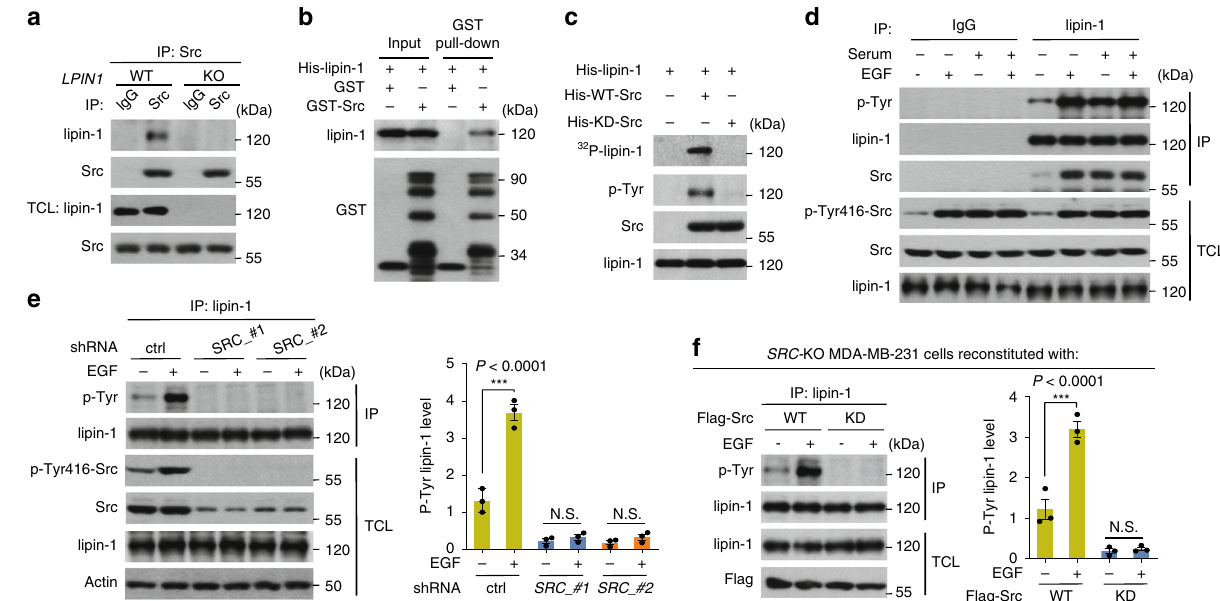
Fig. 1 Src directly interacts with and phosphorylates lipin-1 upon mitogenic stimulation. a Interaction between endogenous lipin-1 and Src. Src in wild- type (WT) and LPIN1- knockout (KO) MDA-MB-231 cells were immunoprecipitated (IP), followed by immunoblotting with antibodies indicated. TCL, total cell lysate. b GST pull-down assay was performed by using bacterially puri fi ed His-lipin-1 and GST or GST-Src, followed by immunoblotting. c Lipin-1 was phosphorylated by Src in vitro. Bacterially expressed His-lipin-1 was incubated with His-WT-Src or His-KD-Src (a kinase-dead form of Src) in a kinase assay buffer, followed by immunoblotting. d Lipin-1 tyrosine phosphorylation stimulated by serum, or/and EGF. MDA-MB-231 cells were maintained in a serum- free medium for 4 h, and then treated with or without EGF, serum or serum plus EGF for additional 30 min. Cell lysates were analysed by immunoblotting with antibodies indicated. e Increased Src-dependent tyrosine phosphorylation of lipin-1 after EGF treatment. MDA-MB-231 cells expressing shRNA against SRC or Renilla as a control were maintained in a serum-free medium for 4 h, followed by stimulation with or without EGF for 30 min. Lipin-1 was immunoprecipitated, followed by immunoblotting. Quanti fi cation of the ratio of phosphorylated lipin-1 to total lipin-1 is displayed as a scatter plot. P-Tyr- lipin-1, phosphorylation of lipin-1 on tyrosine. f The tyrosine phosphorylation of lipin-1 in SRC -KO MDA-MB-231 cells reconstituted with Src. After 30 min of EGF incubation, SRC -KO MDA-MB-231 cells stably expressing Flag-tagged WT-Src or KD-Src were lysed and subjected to IP with anti-lipin-1 antibody. Quanti fi cation of the ratio of phosphorylated lipin-1 to total lipin-1 is displayed as a scatter plot. e , f were quanti fi ed in each biological replicate ( n = 3);